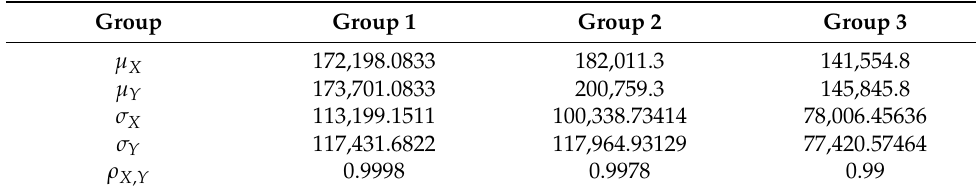
Table 3. Statistical Table of Correlation